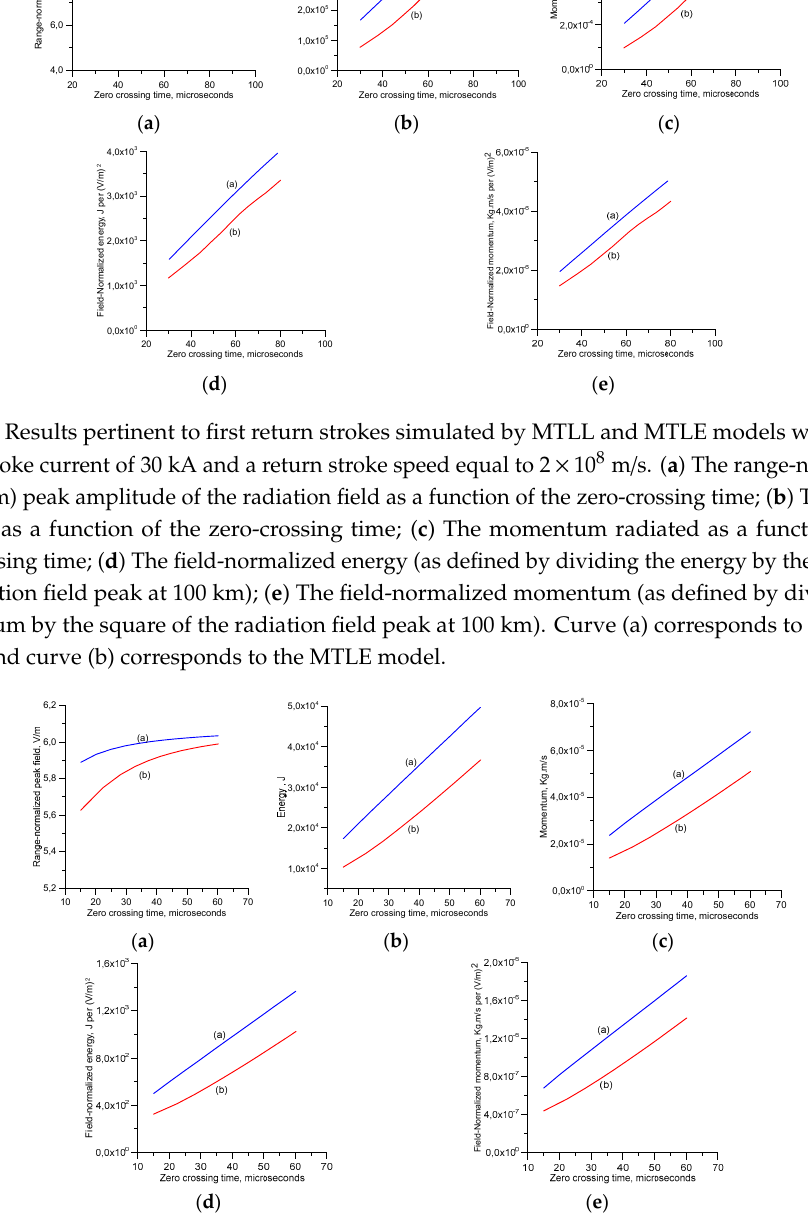
Figure 7. Results pertinent to subsequent return strokes simulated by MTLL and MTLE models with a peak return stroke current of 12 kA and a return stroke speed equal to 8 2.5 10 × m/s. ( a ) The range- normalized (to 100 km) peak amplitude of the radiation field as a function of the zero-crossing time; ( b ) The energy radiated as a function of the zero-crossing time; ( c ) The momentum radiated as a function of the zero-crossing time; ( d ) The field-normalized energy (as defined by dividing the energy by the square of the radiation field peak at 100 km); ( e ) The field-normalized momentum (as defined by dividing the momentum by the square of the radiation field peak at 100 km). Curve (a) corresponds to the MTLL model, and curve (b) corresponds to the MTLE model.